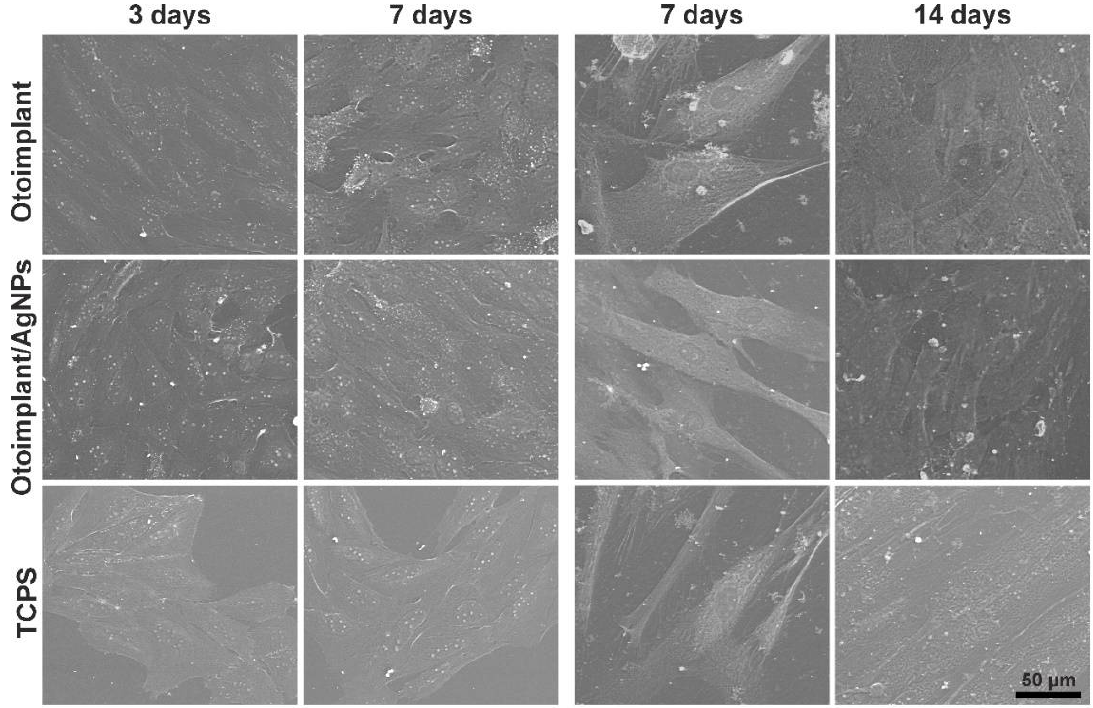
Figure 8. SEM images of Saos-2 cells after three and seven days of culture and NHOst after three and seven days of culture in direct contact with the Otoimplant, Otoimplant/AgNPs, and TCPS. Magnification 1000×.